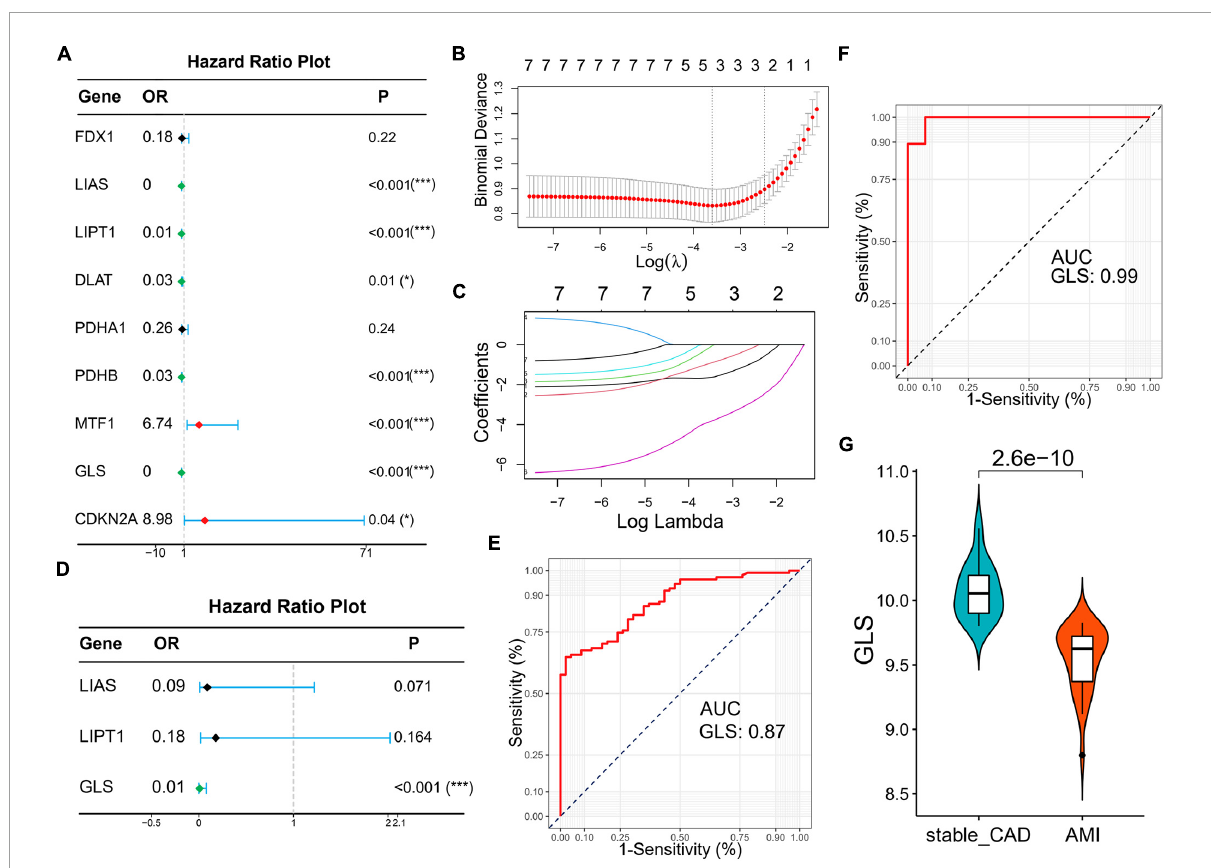
FIGURE7 Identification of diagnostic markers for AMI based on logistic regression and lasso analysis. (A) The forest map of univariate logistic regression. (B) Log (Lambda) value of the seven genes in the lasso model. (C) The most proper log (Lambda) value in the lasso model. (D) The forest map of multivariate logistic regression. (E,F) The ROC curve of GLS in the training set and verification set, respectively. (G) The violin diagram of GLS differential expression is in the validation set (stable_CAD, stable coronary heart disease; AMI, acute myocardial infarction). * P < 0.05, *** P <